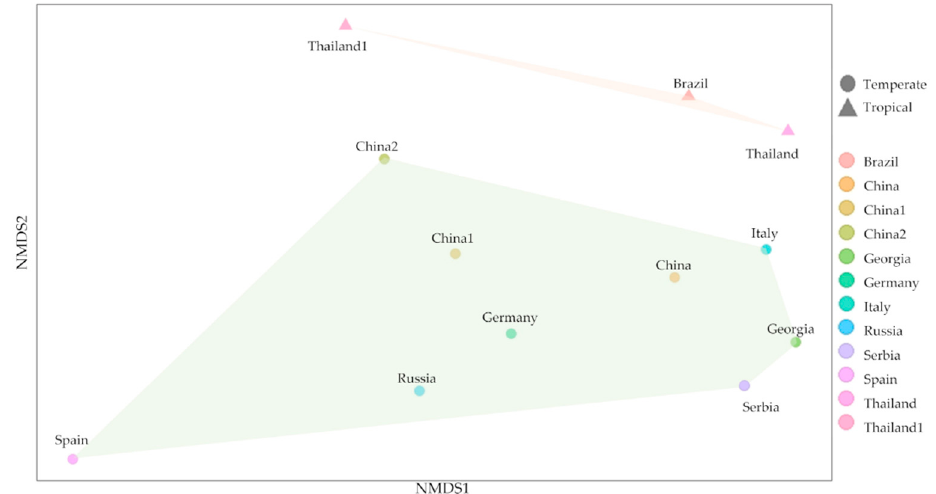
Figure 8. Microorganism diversity comparison among different countries. The triangles are communities from tropical countries (Thailand and Brazil), while circles are communities from temperate countries (China, Georgia, Germany, Italy, Russia, Serbia and Spain).